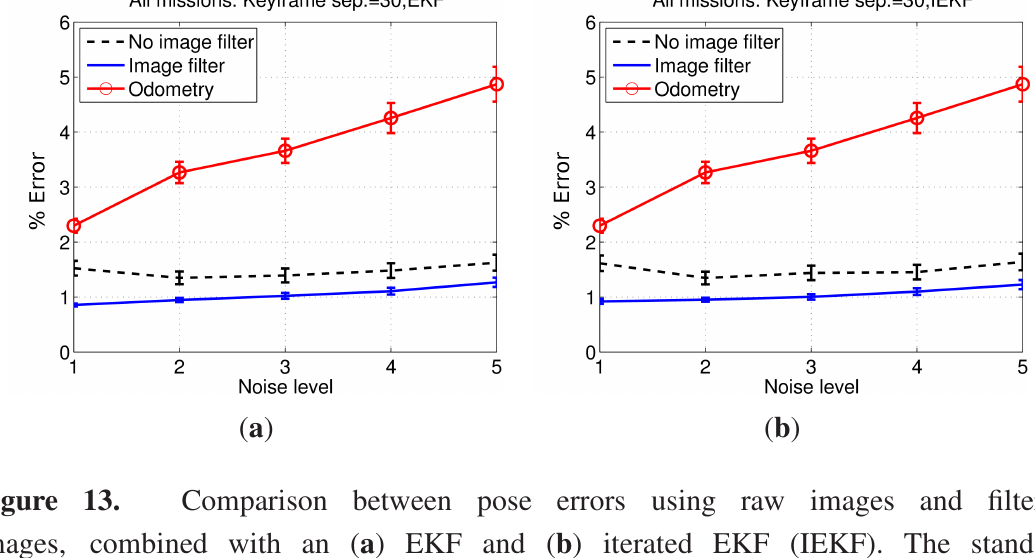
Figure 13. Comparison between pose errors using raw images and filtered images, combined with an ( a ) EKF and ( b ) iterated EKF (IEKF). The standard deviation is depicted as 0.1 σ to provide a clear representation. Noise levels represent the covariance of the synthetic zero-mean Gaussian noise added to odometry, ranging from Noise Level 1 ( [Σ , Σ , Σ ( [Σ ] = [4 × 10 − 5 , 4 × 10 − 5 , 5 × 10 − 4 ] ). x y θ